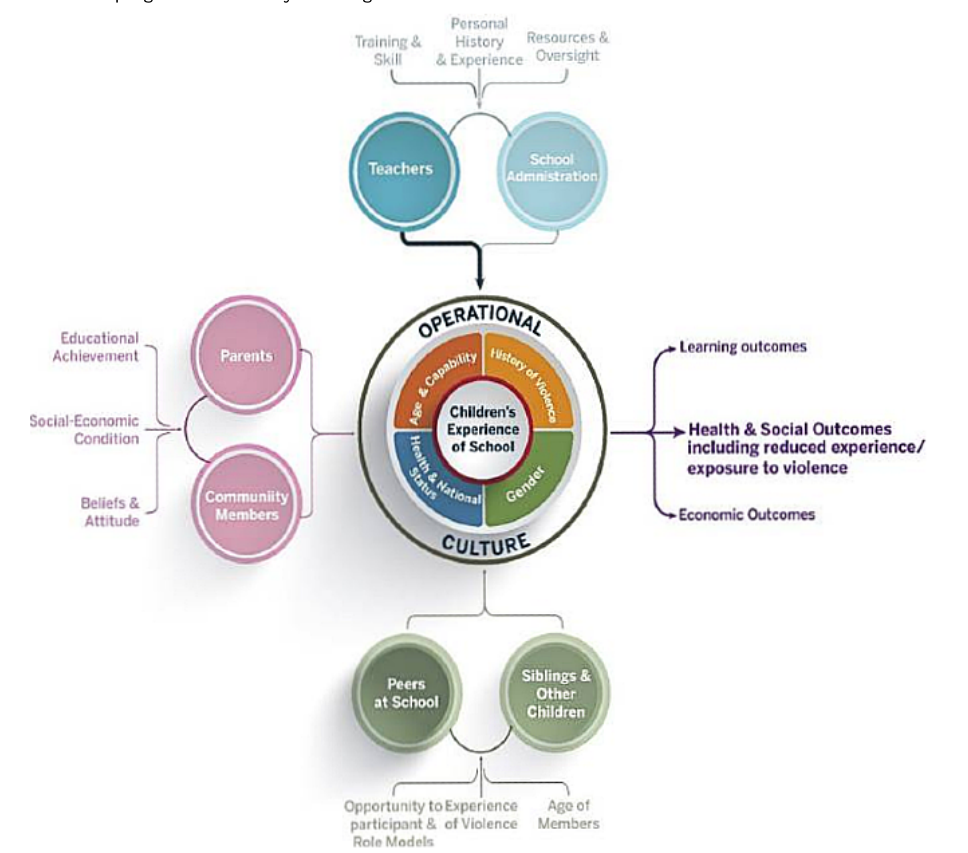
Figure 1. Good School Toolkit programmatic theory of